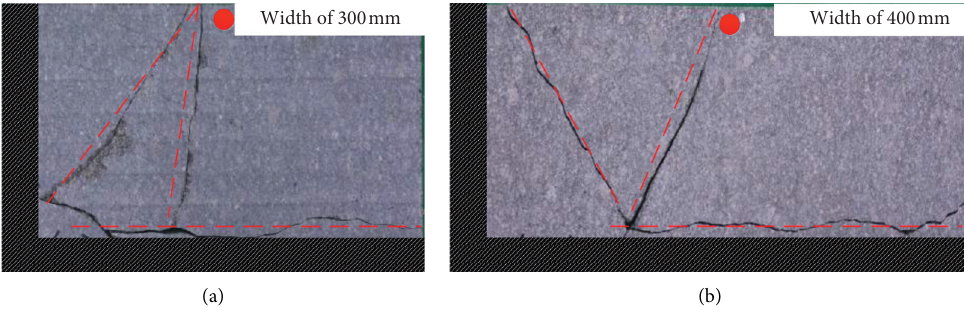
Figure 17: The cutting force at different thickness of rock plate. (a) 300mm and (b) 400mm.